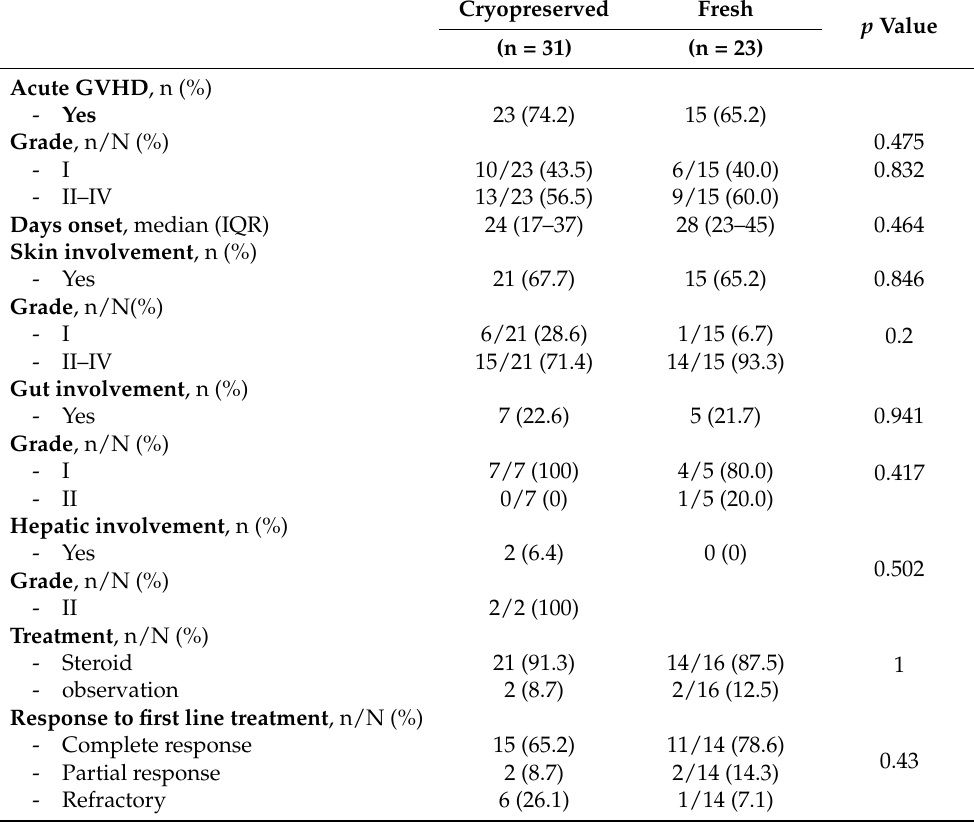
Table 2. Acute GVHD characteristics.